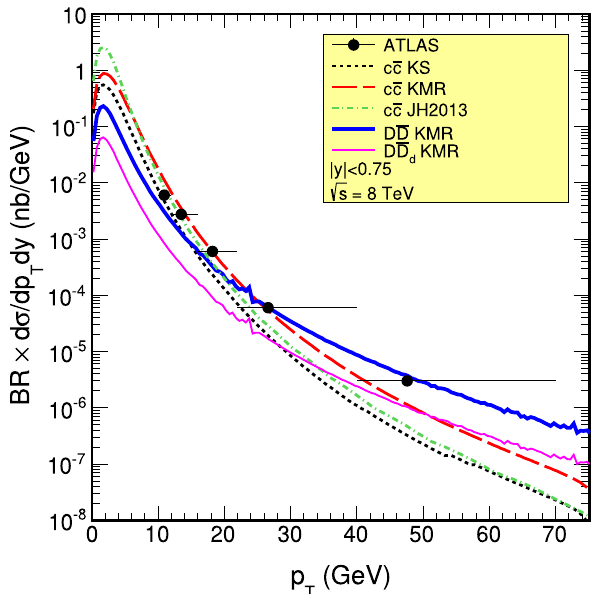
Fig. 4 Transverse momentum distribution of X ( 3872 ) for the ATLAS experiment. Shown are results for 3 different gluon uPDFs. Here BR = 0 . 038 · 0 . 0596. The upper limit for the SPS molecular scenario is shown as the thick solid line. The thin solid line shows the molecular scenario neglecting the feeddown component of D 0 , ¯ D